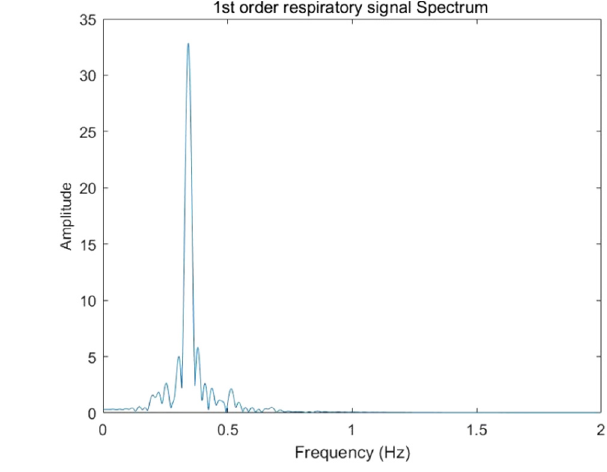
Figure 18. Amplitude-frequency characteristic of Butterworth filter for respiratory signal extraction. The restored respiratory signals and their spectra are shown in Figure 19.